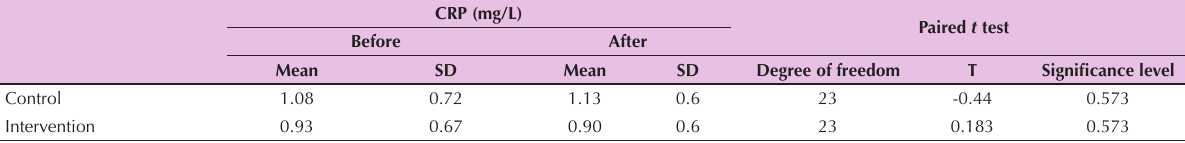
Table 3. The mean and standard deviation of CRP before and after the exercise in both groups